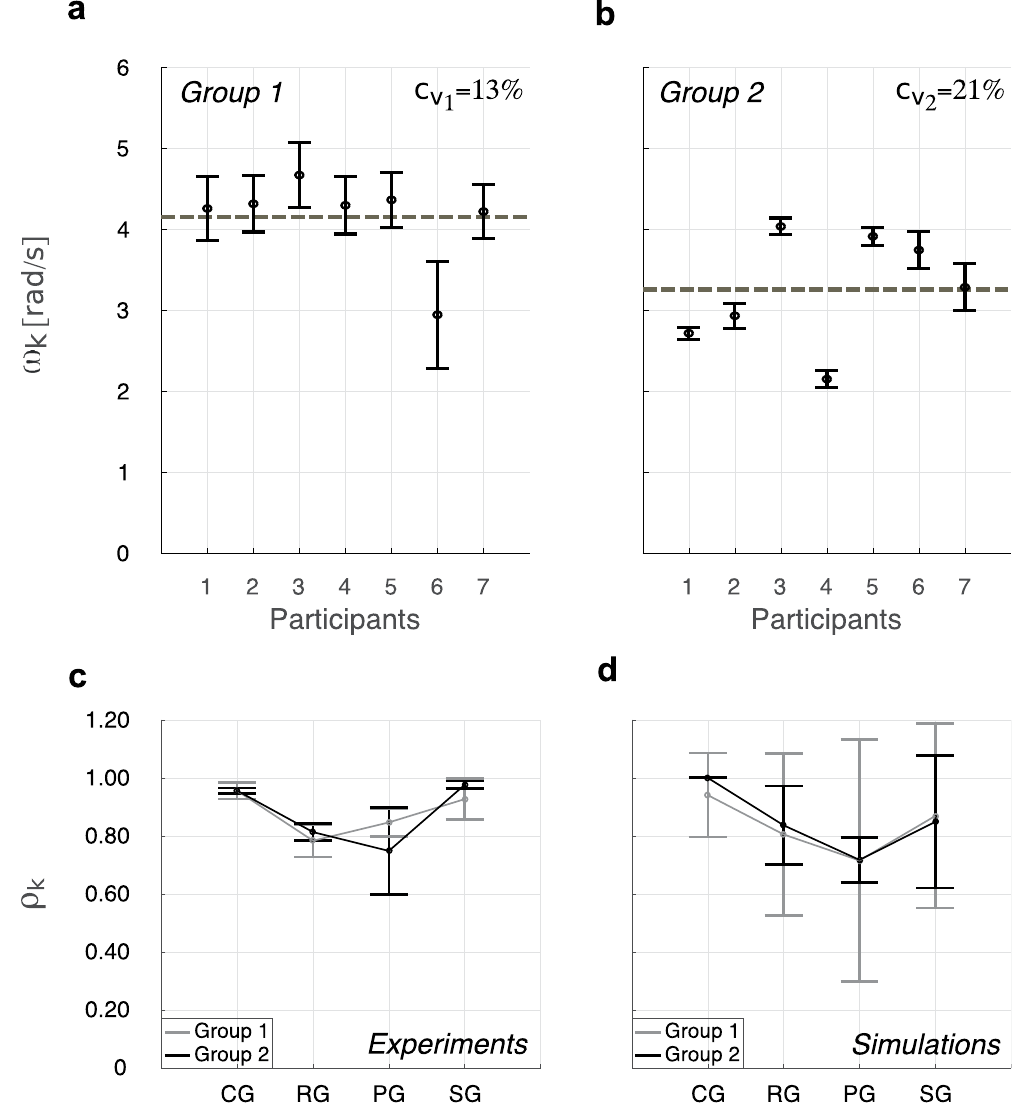
Figure 1. Natural oscillation frequencies and individual synchronisation indices ρ k for each group and topology. Mean (black circle) and standard deviation (black error bar) of the natural oscillation frequencies ω of the participants in Group 1 ( a ) and Group 2 ( b ) are presented. The frequencies of Group 2 are distributed further from their mean value averaged over the total number of players (grey dashed line) than those of Group 1, as quantified by their respective coefficient of variation c v , which is equal to = c 13% = c 21% for Group 2. Individual synchronisation indices are presented for experiments ( c ) and numerical v 2 simulations ( d ). Mean values over the total number of participants are represented by circles, and standard deviations by error bars (grey for Group 1, black for Group 2). CG: Complete graph, RG: Ring graph, PG: Path graph, SG: Star